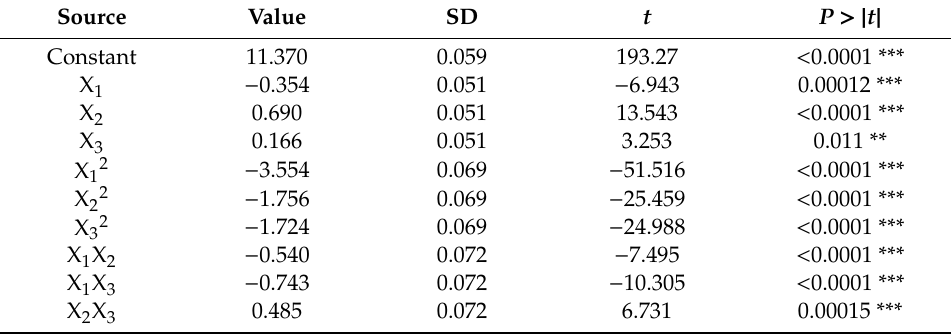
Table 3. Statistical analysis of the regression coe ffi cients of USAE of TPC from AOR. Source Value SD t P > | t | Constant 11.370 0.059 193.27 < 0.0001 *** X 1 − 0.354 0.051 − 6.943